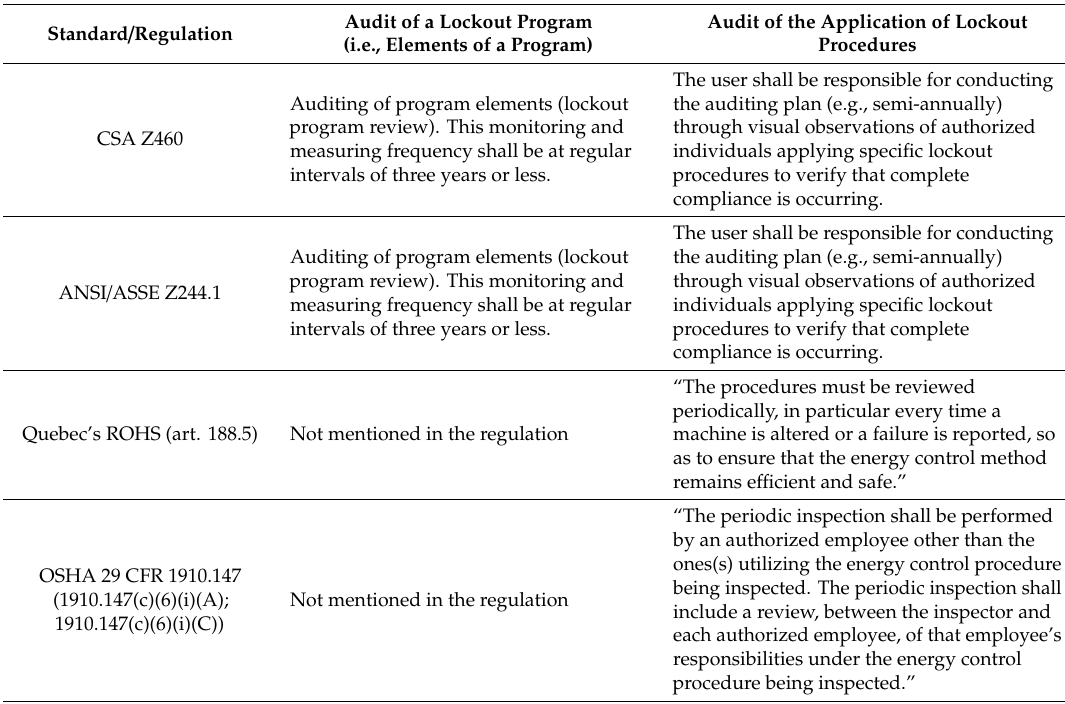
Table 1. Audits of lockout in North American standards and